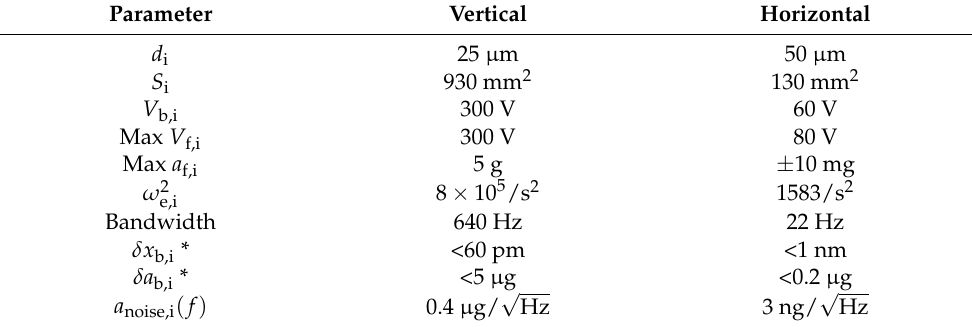
Table 1. The general parameters of the accelerometer. Parameter